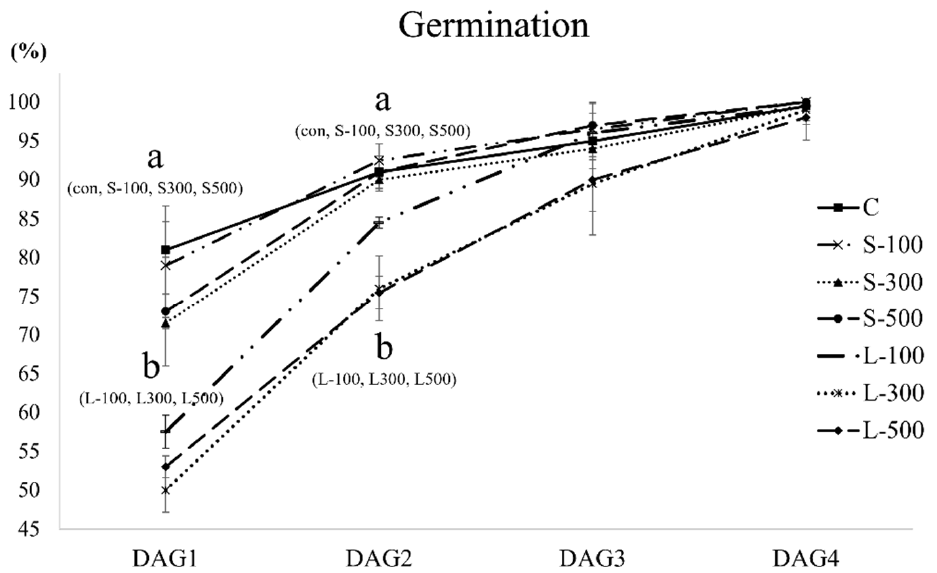
Figure 2. Gamma radiation dose and exposure time effects on seed germination percentage. The seed germination percentages were determined daily for 4 days. DAG, days after germination. Each bar represents the mean ± SD.